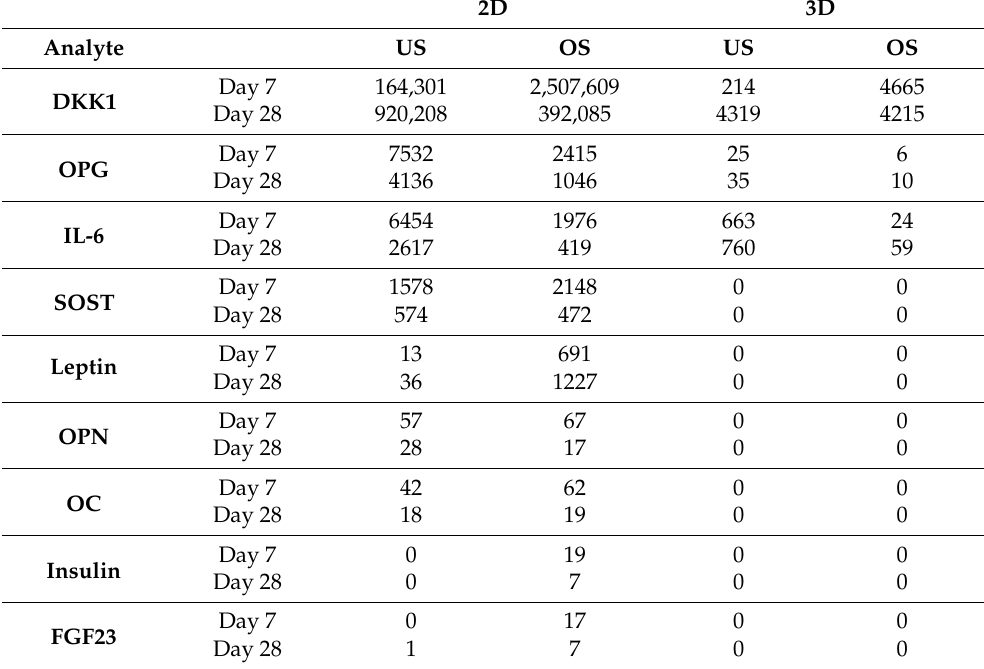
Figure 7. Quantification of bone metabolism-affecting factors released from unstimulated (US) and osteogenically stimulated (OS) 2D and 3D spheroid cultures after 7 and 28 days. ( a ) DKK1; ( b ) OPG; ( c ) IL-6; ( d ) leptin; ( e ) SOST (concentrations were normalized to cell number, n = 4; # significantly different from 2D cultures at the respective time point; * significantly different from day 7 under the same cultivation conditions; § significantly different from US culture at the respective time point and the dimension of cultivation; one-way ANOVA and two-way ANOVA, post hoc uncorrected Fisher’s LSD; # p < 0.05; * p < 0.05; § p < 0.05). Table 1. Quantification of bone metabolism-affecting factors in cell culture supernatants of un- stimulated (US) and osteogenically (OS) stimulated 2D and 3D spheroid cultures (multiplex assay, biological replicates: n = 4, technical replicates were involved in the calculations, median values in pg/10 4 cells, descending order depending on detected